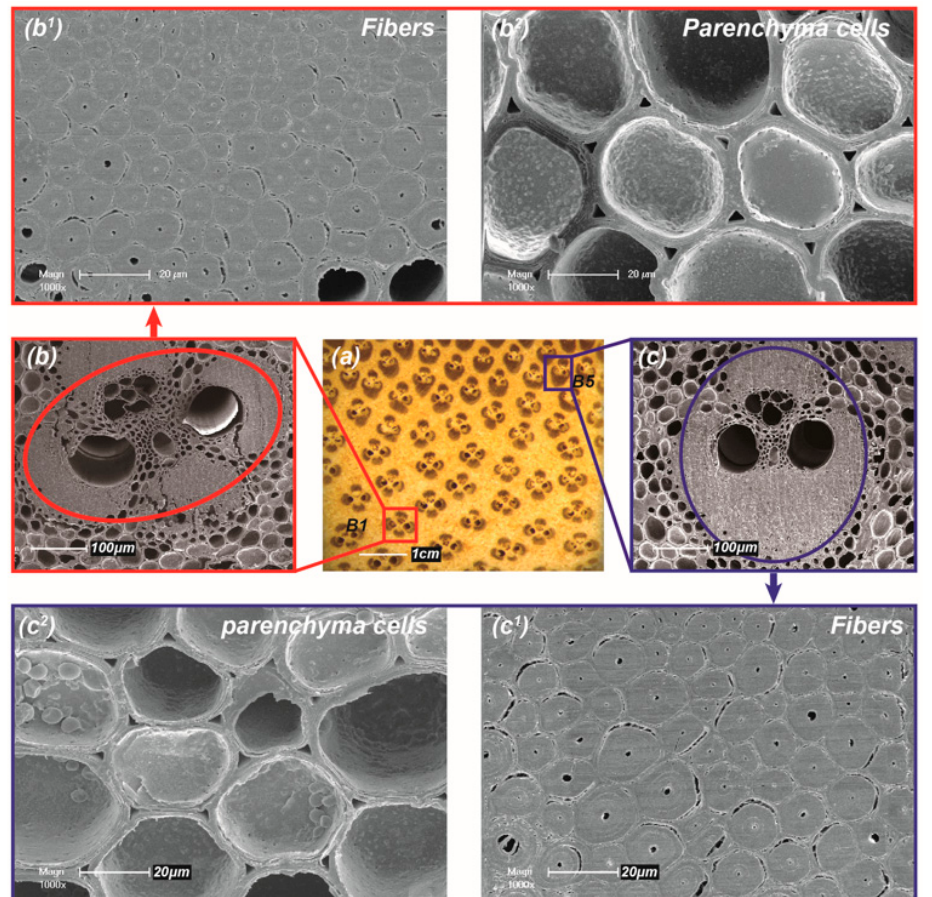
Figure 6. ( a ) Optical microscope picture of FG structure on bamboo culm cross section; the shape of vascular bundles with symmetrical ( b ) and directional ( c ) structure and morphology of fibers ( b 1 , c 1 ) and parenchyma cells ( b 2 , c 2 ) in the inner layer and outer layer, respectively.